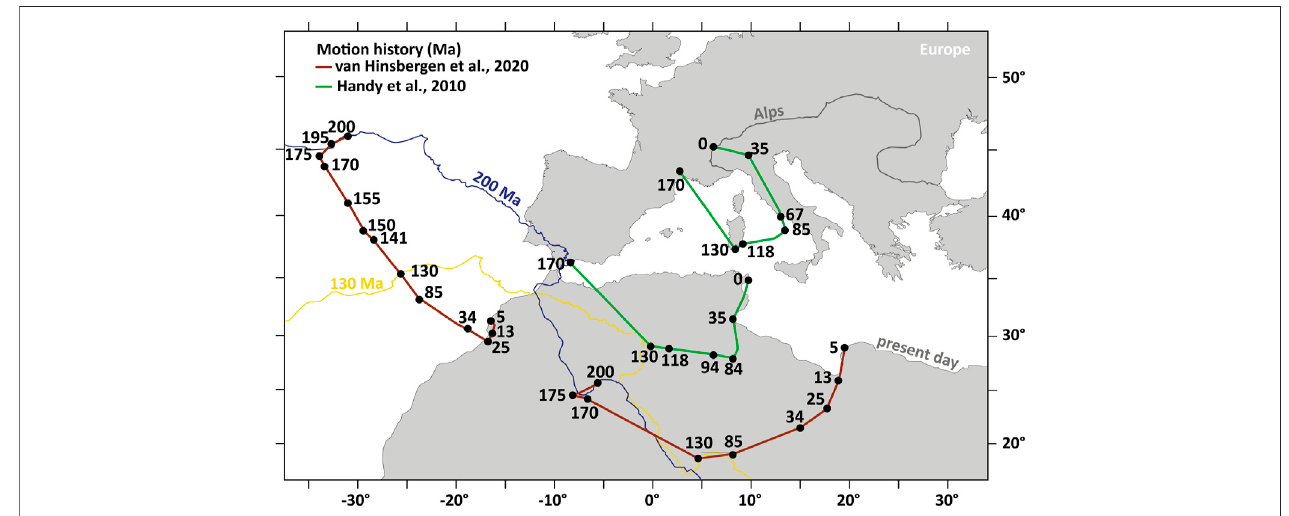
FIGURE 9 | Plate motion history of Africa with respect to Europe from the Triassic to present day modi fi ed after van Hinsbergen et al. (2020). Red and green lines represents the motions path calculated by van Hinsbergen et al. (2020) and Handy et al. (2010), respectively. Numbers are ages in Ma. The yellow and blue lines represent the outline of Africa and illustrate its position at 200 Ma and 130 Ma (van Hinsbergen et al., 2020). The motion paths highlight a period of slow Africa-Europe convergence between 130 and 90 Ma, which is key for the future development of a subduction zone along the Adriatic passive margin.